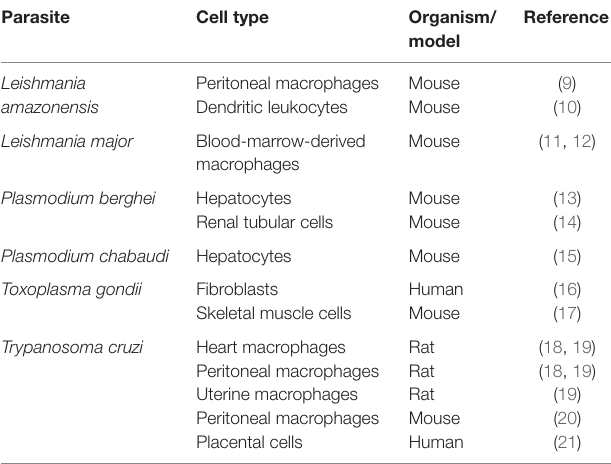
TABLe 1 | Protozoan parasite-induced lipid body formation in host